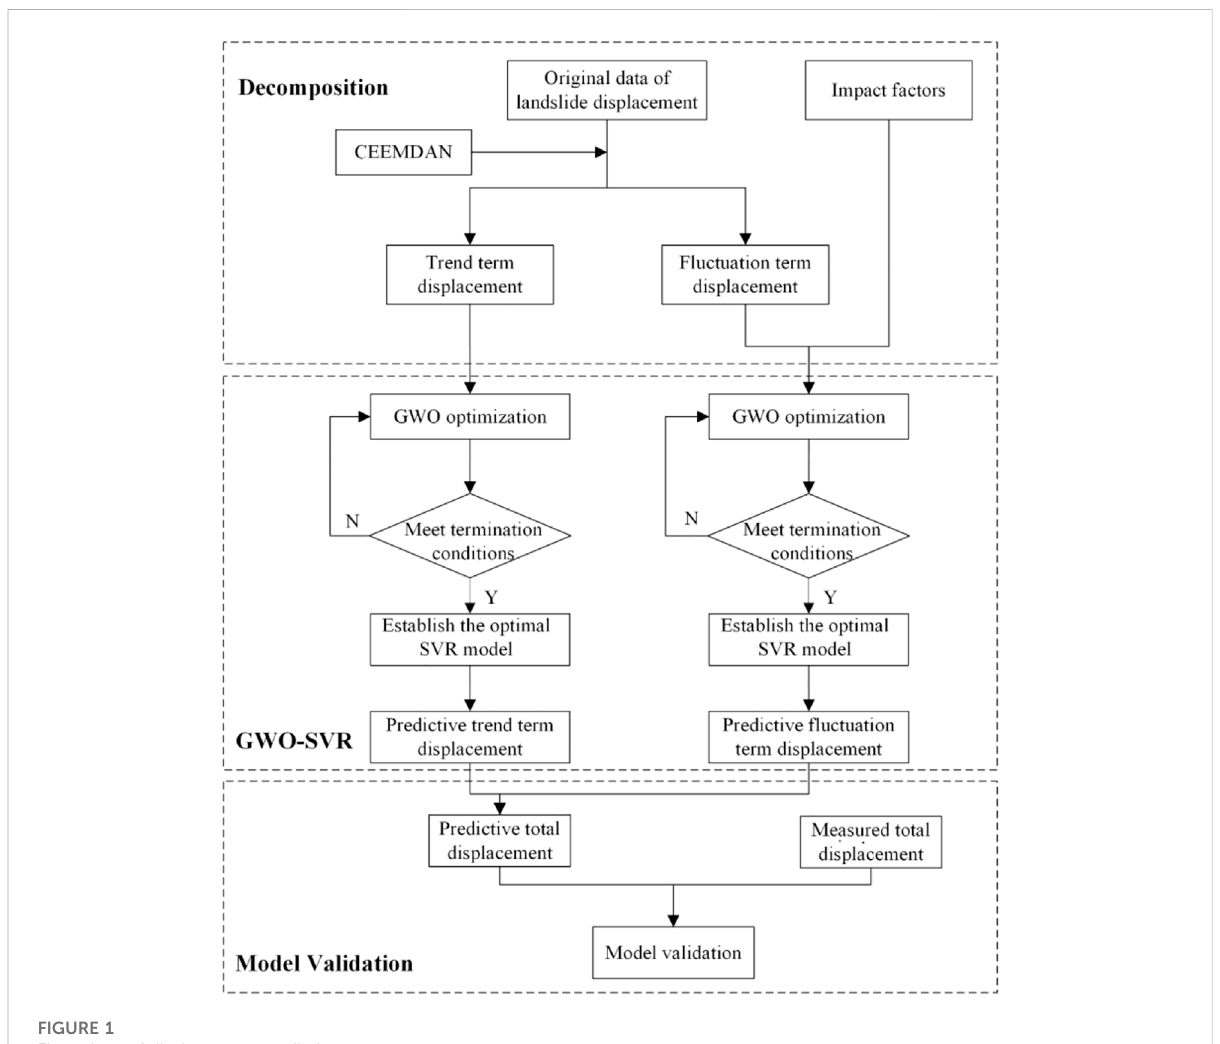
FIGURE 1 Flow chart of displacement